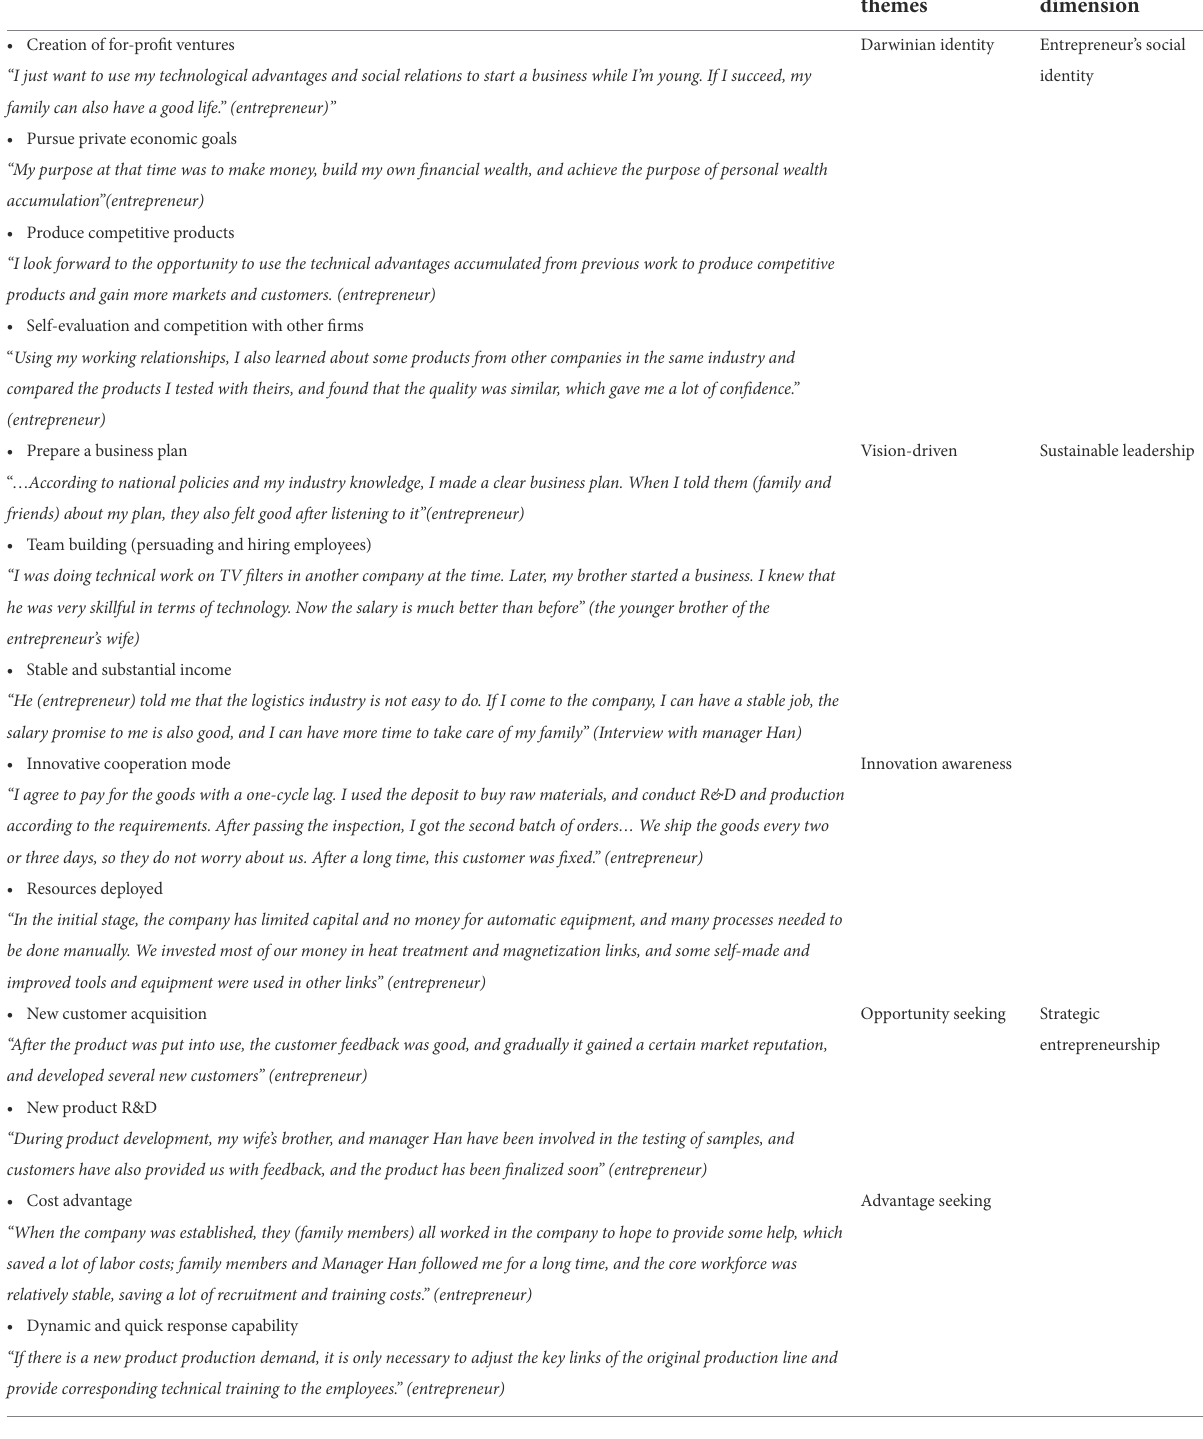
TABLE 4 Typical examples and coding results for the initial stage